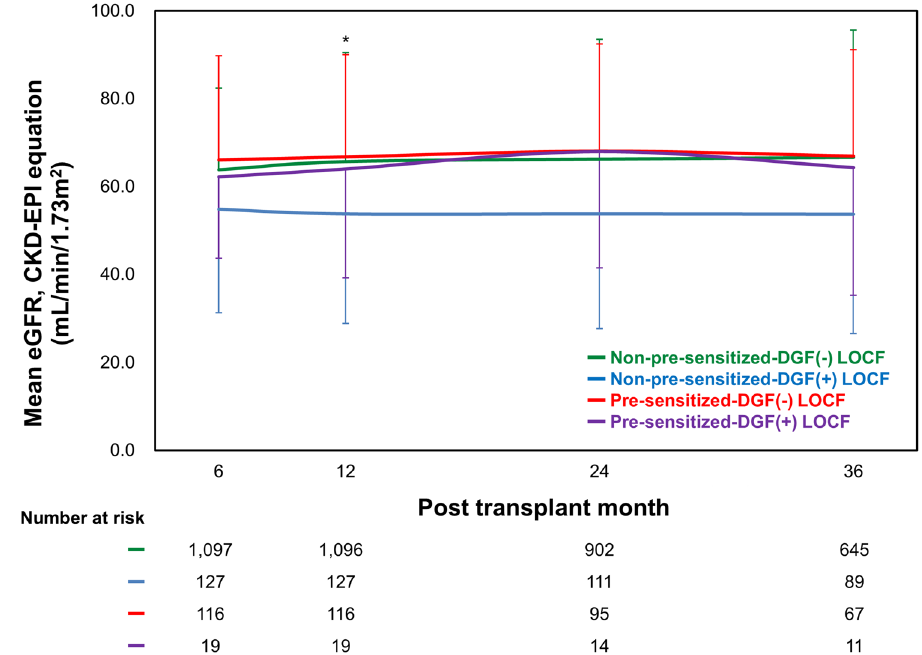
Figure 2. Comparison of the time-related changes in allograft function based on eGFR using CKD-EPI equation (mL/min/1.73 m 2 ) according to DGF and pre-sensitization status. During 36 months, the non-pre- sensitized-DGF(+) subgroup showed the lowest allograft function compared with other subgroups. eGFR Estimated glomerular filtration rate, CKD-EPI chronic kidney disease-epidemiology collaboration, DGF delayed